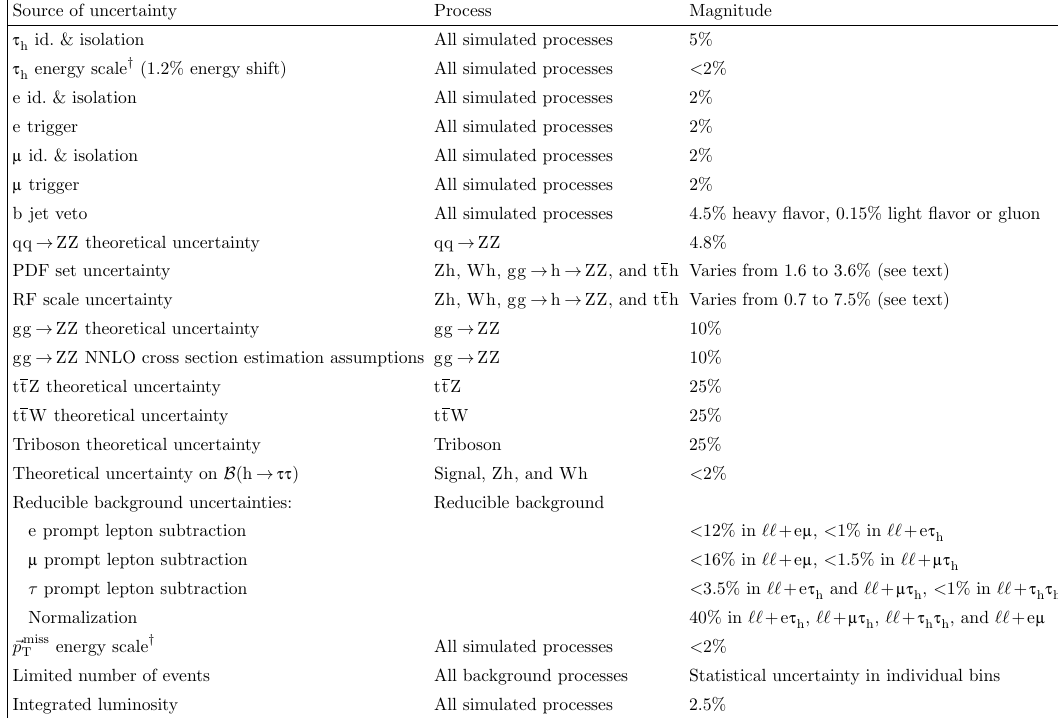
Table 3 . Sources of systematic uncertainty. The sign y marks the uncertainties that a(cid:11)ect both the shape and normalization of the (cid:12)nal m c distributions. Uncertainties that only a(cid:11)ect the nor- ‘‘ tt malizations have no marker. For the shape and normalization uncertainties, the magnitude column lists an approximation of the associated change in the normalization of the a(cid:11)ected processes. senting the systematic uncertainties, are pro(cid:12)led in the (cid:12)t. Even though the studied